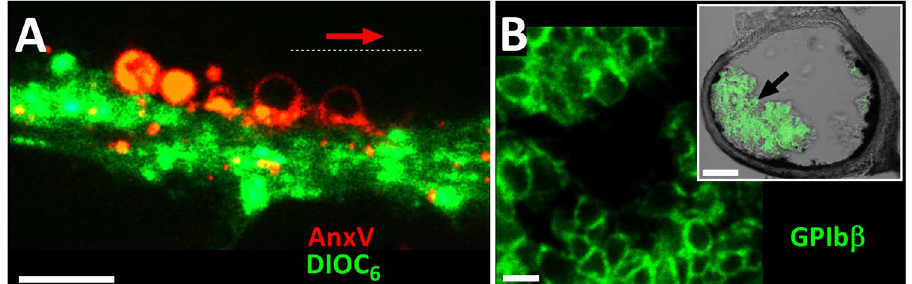
Figure 5. Ballooned platelets are seen after in vitro blood flow over collagen and at wound site. ( A ) Whole human blood stained with DIOC 6 (green) and flowed at 1000s- 1 over collagen (50 µ g/ml) coated surface show ballooned platelets exposing PS (Alexa568-Annexin-V, red) after flow. Red arrow indicates the direction of blood flow. ( B ) Thrombus formed after ferric chloride injury of mouse carotid artery. Platelets were labelled with 488 Dylight conjugated anti-GPIb β antibody (green) and visualized by super-resolution microscopy (Stimulated Emission Depletion). Cross-section of carotid artery at point of damage is shown in insert, with fluorescent GPIb β images overlaid on phase contrast. Magnified image of region indicated by black arrow in insert, demonstrate the appearance of ballooned platelets in the structure of the thrombus. Scale bar represents 5 µ m (A,B) and 60 µ m (insert on B). Data are representative of 6 independent